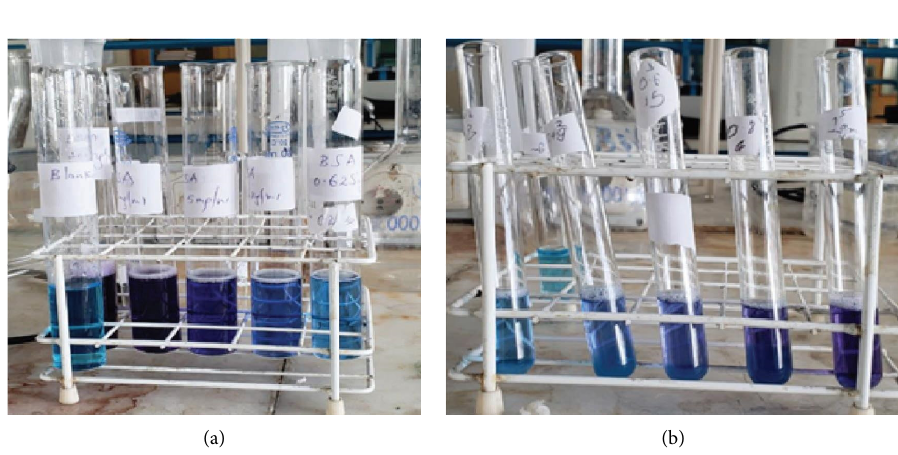
Figure 3: Standard solution preparations for curve development (a) 10–0.625mg/ml and (b)